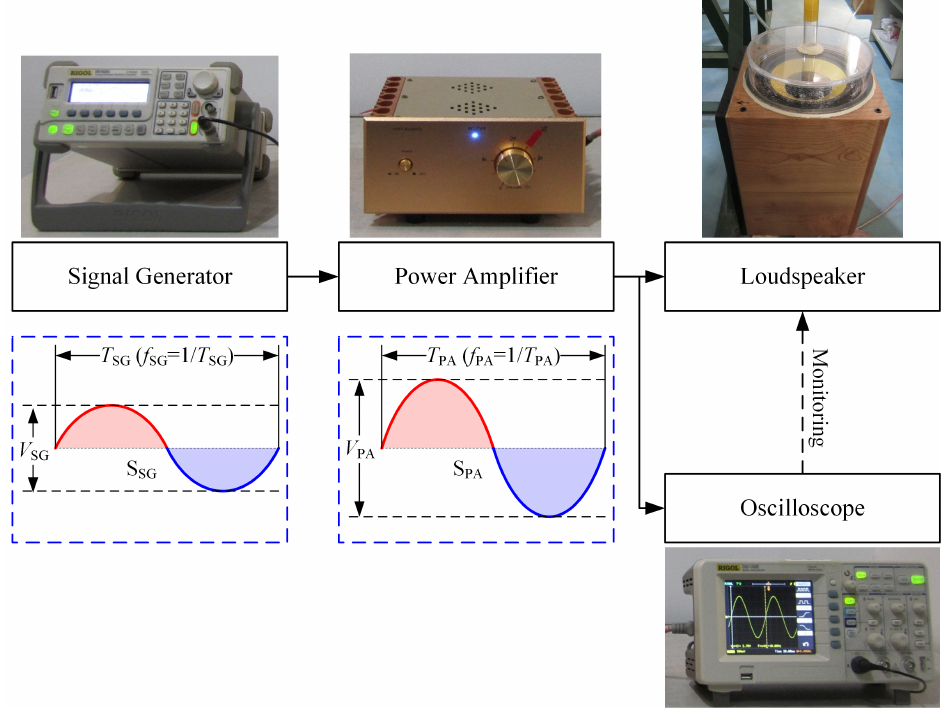
Figure 1. Photographs of the actuator components and operating procedure of the synthetic jet